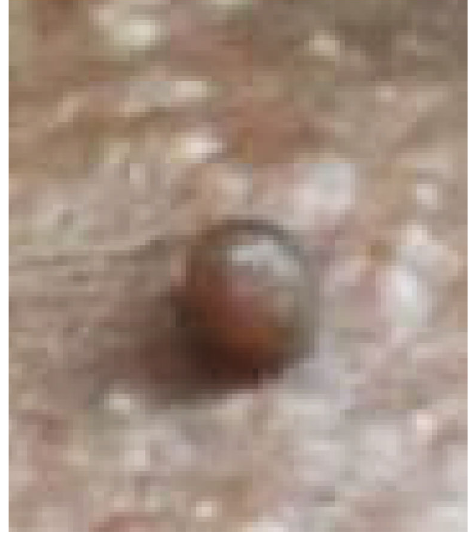
Figure 4: A single well-circumscribed and translucent